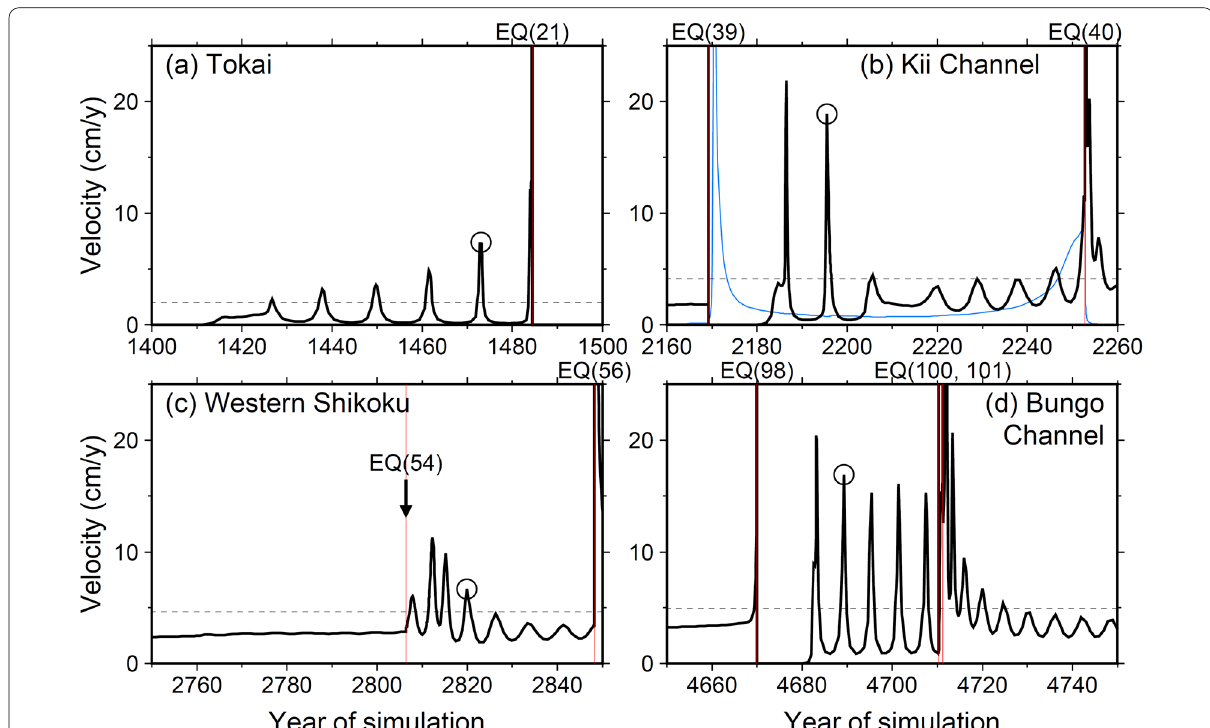
Fig. 12 Details of Fig. 11 showing the time evolution of slip velocity during 100-year periods of the simulation in the a Tokai, b Kii Channel, c western Shikoku, and d Bungo Channel segments (shaded periods in Fig. 11). Earthquakes (EQ) are labeled with red lines and event numbers are in parentheses. Circles denote events illustrated in Fig. 13. Blue line in b indicates the time evolution of slip velocity at point X in Fig.